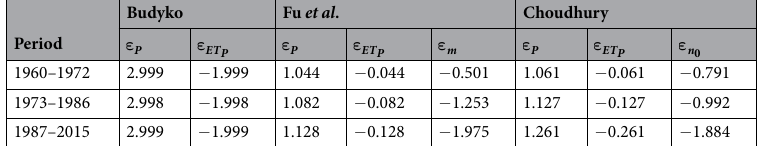
Table 4. The elasticity of streamflow alterations on climate variability and human activities.